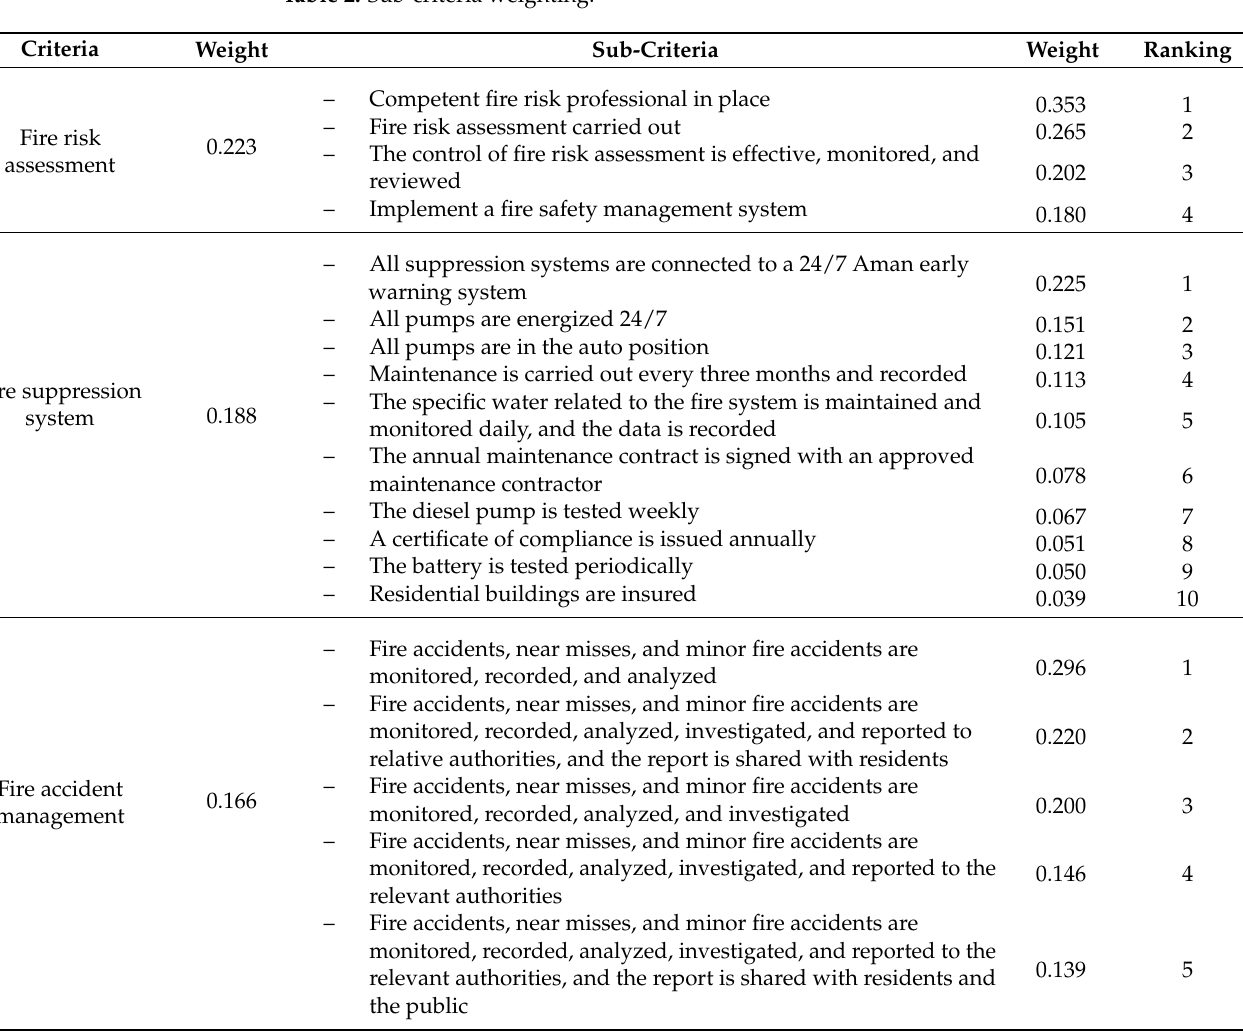
Table 2. Sub-criteria